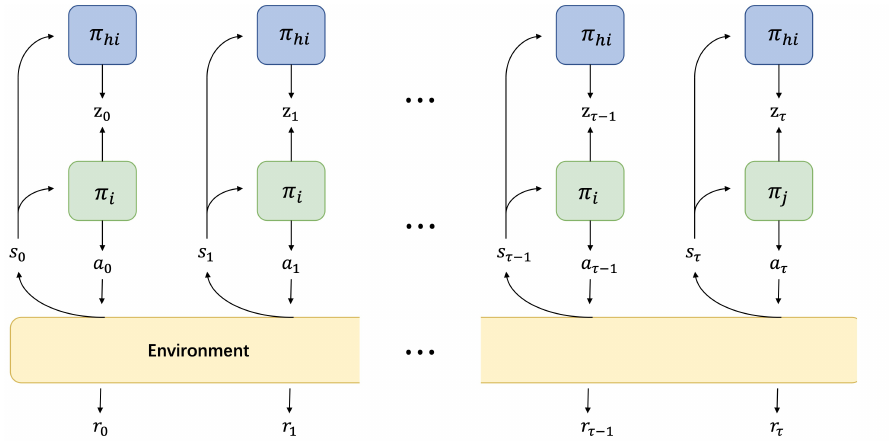
Figure 2. Unlike existing work, in the Admission algorithm, the high-level policy π hi must make a choice every timestep. When the high-level policy π hi changes its choice, it receives a small negative